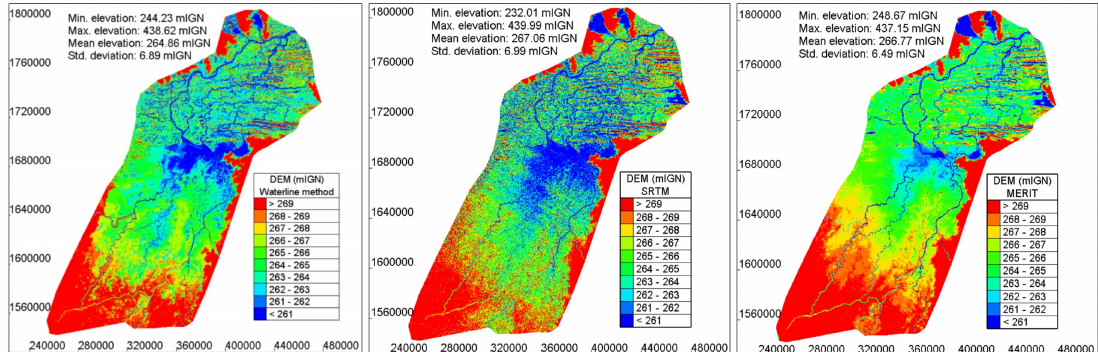
Figure 3. Digital elevation model derived from the waterline method ( left ), Shuttle Radar Topography Mission (SRTM) ( middle ), and Multi-Error-Removed Improved-Terrain (MERIT DEM) ( right ).